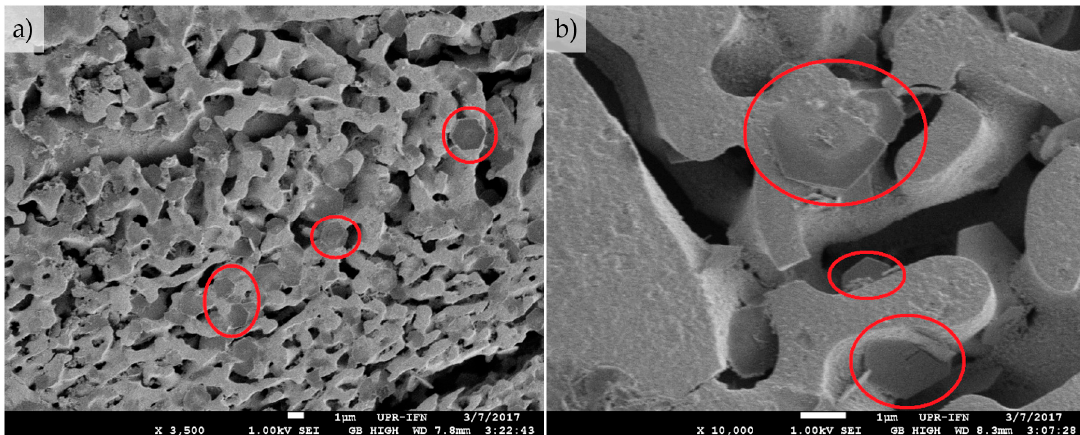
Figure 12. SEM images of: ( a ) a HC-2 sample with formation of aluminum hydroxide during selective dissolution and; ( b ) SEM image with more magnification than ( a ).